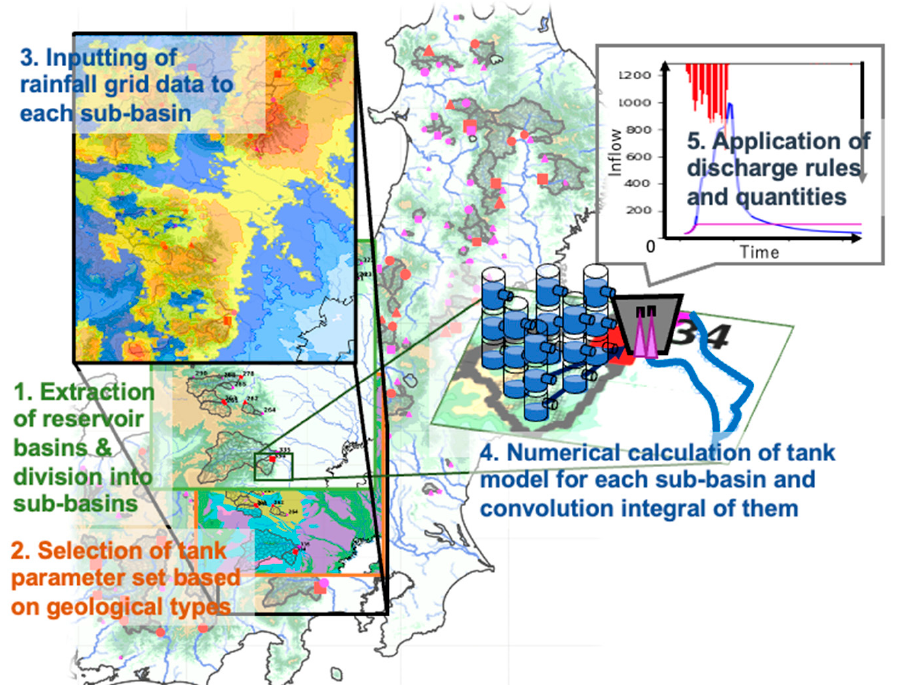
Figure 3. Outline of the nationwide rainfall–runoff reservoir model. First, reservoir basins’ information was obtained. Dam location data [21] and grid data containing flow direction and area for all of Japan with a spatial resolution of 15 arc seconds (~500 m) [22] were used. The schematic illustration of the method is shown in Figure 4. First, the grids where dams are located were identified. Then, the grids that flow into these reservoirs was regarded as reservoir basins (a). Furthermore, each reservoir basin was divided into sub-basins whose areas comprised about 15–18 km 2 or 1 km 2 depending on the reservoir catchment area (b). Finally, river lengths were calculated for the estimation of approximate propagation delay (c).